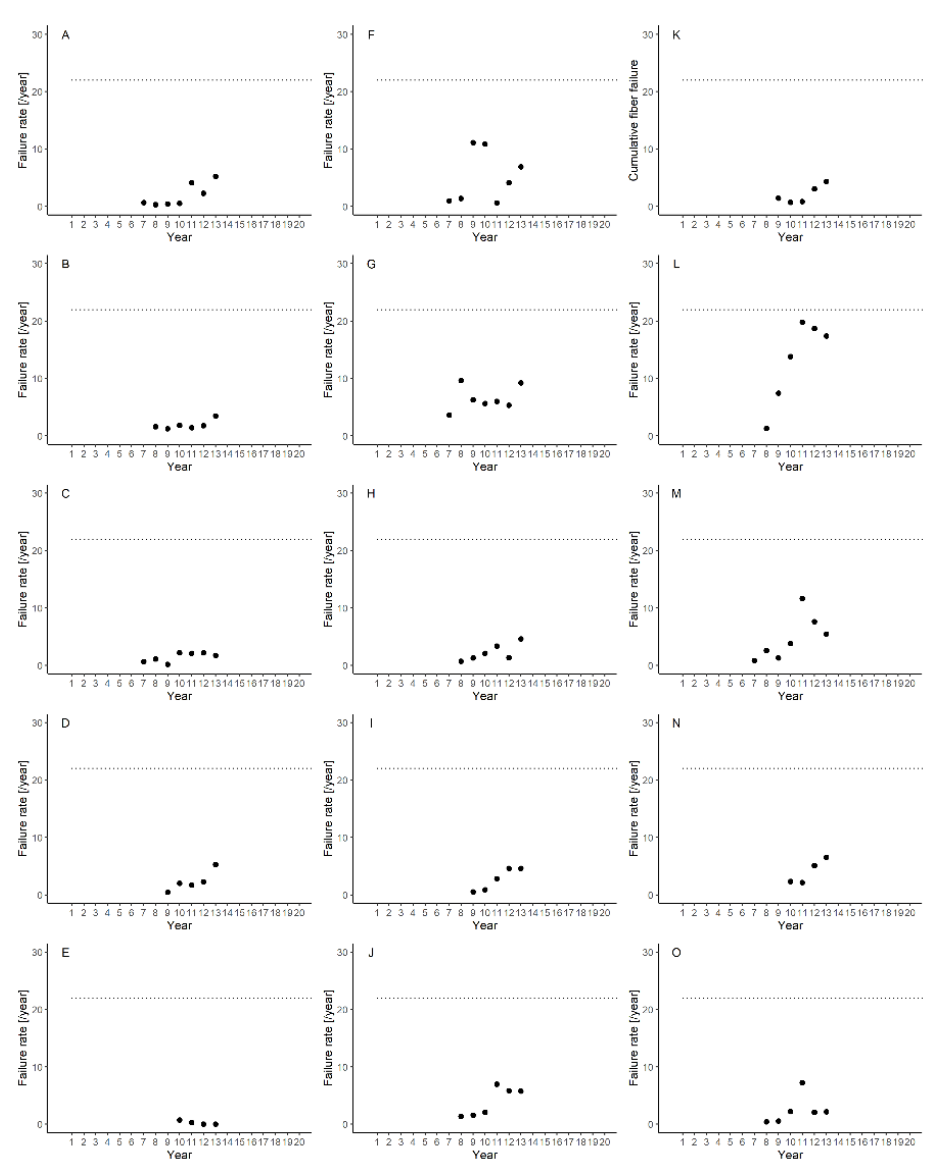
Figure A1. Failure rate (failure per year) for each membrane module. Train 1: ( A – E ); Train 2: ( F – J ); and Train 3: ( K – O ). Dotted lines indicate the permissible failure rate for LRV 2 (black).